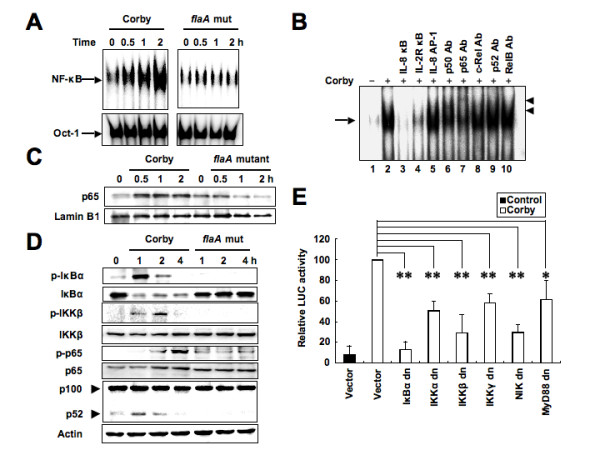
NF-κB signal is essential for flagellin-dependent activation of the IL-8 promoter by L. pneumophila. (A) Flagellin is required for induction of NF-κB binding activity. Nuclear extracts from Jurkat cells infected with Corby or flaA mutant were mixed with IL-8 NF-κB probe (MOI, 100:1). (B) Sequence specificity of NF-κB binding activity and characterization of proteins that bound to the NF-κB binding site. Competition assays were performed with nuclear extracts from cells infected with Corby for 2 h. 100-fold excess amounts of competitor were added (lanes 3 to 5). A supershift assay in the same nuclear extracts also was performed. Antibodies (Ab) were added (lanes 6 to 10). Arrows indicate specific complexes, while arrowheads indicate the DNA binding complexes supershifted. (C) Flagellin-induced p65 translocation. Cells were infected with Corby or flaA mutant. Nuclear extracts were subjected to immunoblotting. (D) Flagellin activates NF-κB through the classical and alternative pathways. Cells were infected with Corby or flaA mutant. Lysates were subjected to immunoblotting. (E) Overexpression of dominant negative mutants inhibits L. pneumophila-induced activation of the IL-8 promoter. Cells were transfected with -133-luc and the mutant plasmids and then infected with Corby for 6 h. The solid bar indicates luciferase activity of -133-luc and empty vector without infection. Activity is expressed relative to that of cells transfected with -133-luc with further Corby infection, which was defined as 100. Data are means ± SD values of three experiments. dn, dominant negative. *, P < 0.05; **, P < 0.001 (by Student t test).